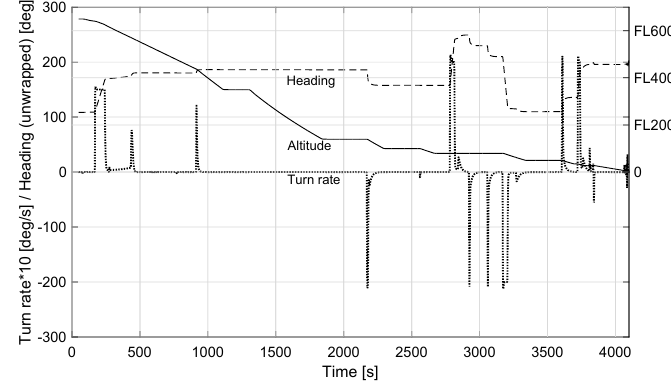
Figure 13. Simulated NS872 turn profile back into